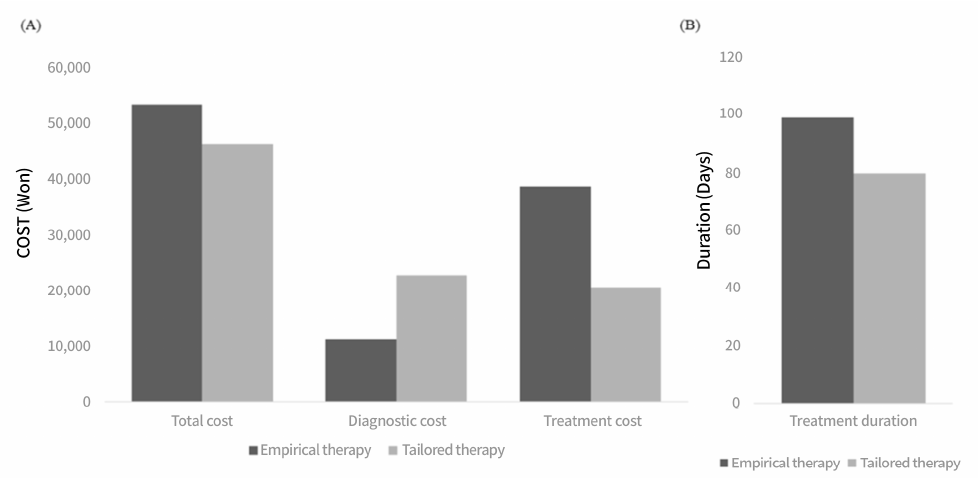
Figure 1. The total medical cost and treatment duration in patients on tailored therapy vs. empirical therapy ( A ) The total medical cost consisting of diagnostic and treatment cost in patients treated with tailored and empirical therapy. ( B ) The duration of treatment for each ultimately successful eradication in patients treated with tailored and empirical therapy.